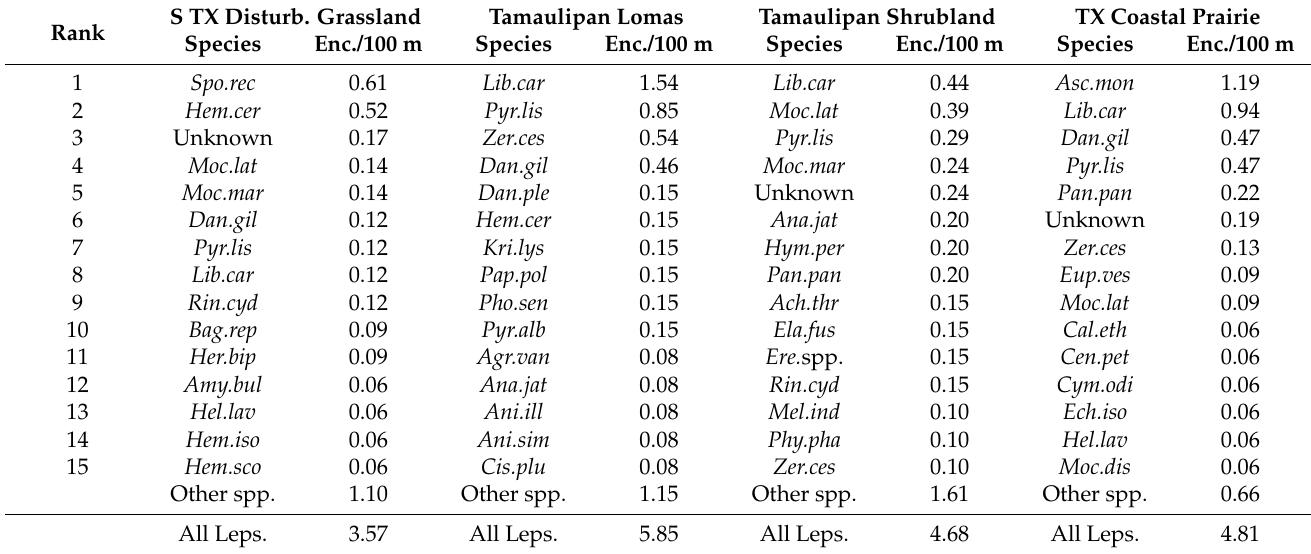
Table 2. Lists of the 15 most abundance Lepidoptera species observed within the four focal habitat classes in the Lower Rio Grande Valley of south Texas, ordered by abundance. Survey effort varied among habitat classes, so abundance was normalized and quantified as the number of individuals of a given species encountered per 100 m of survey distance. Full species names and taxonomic information corresponding to the species codes shown here are found in Table S2 (the full Lepidoptera species list). Legend: enc., encounters; spp., species; Leps., Lepidopterans.